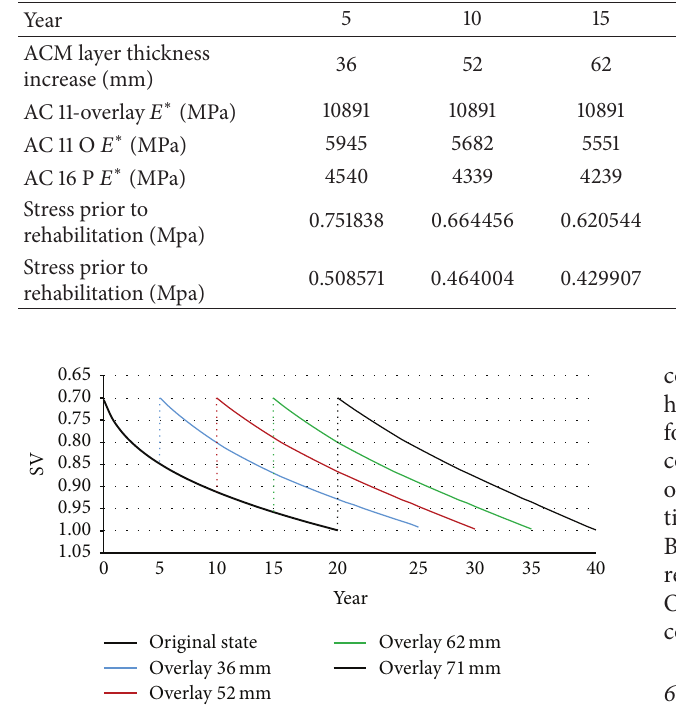
Figure 9: Rehabilitation design at various stages of the life